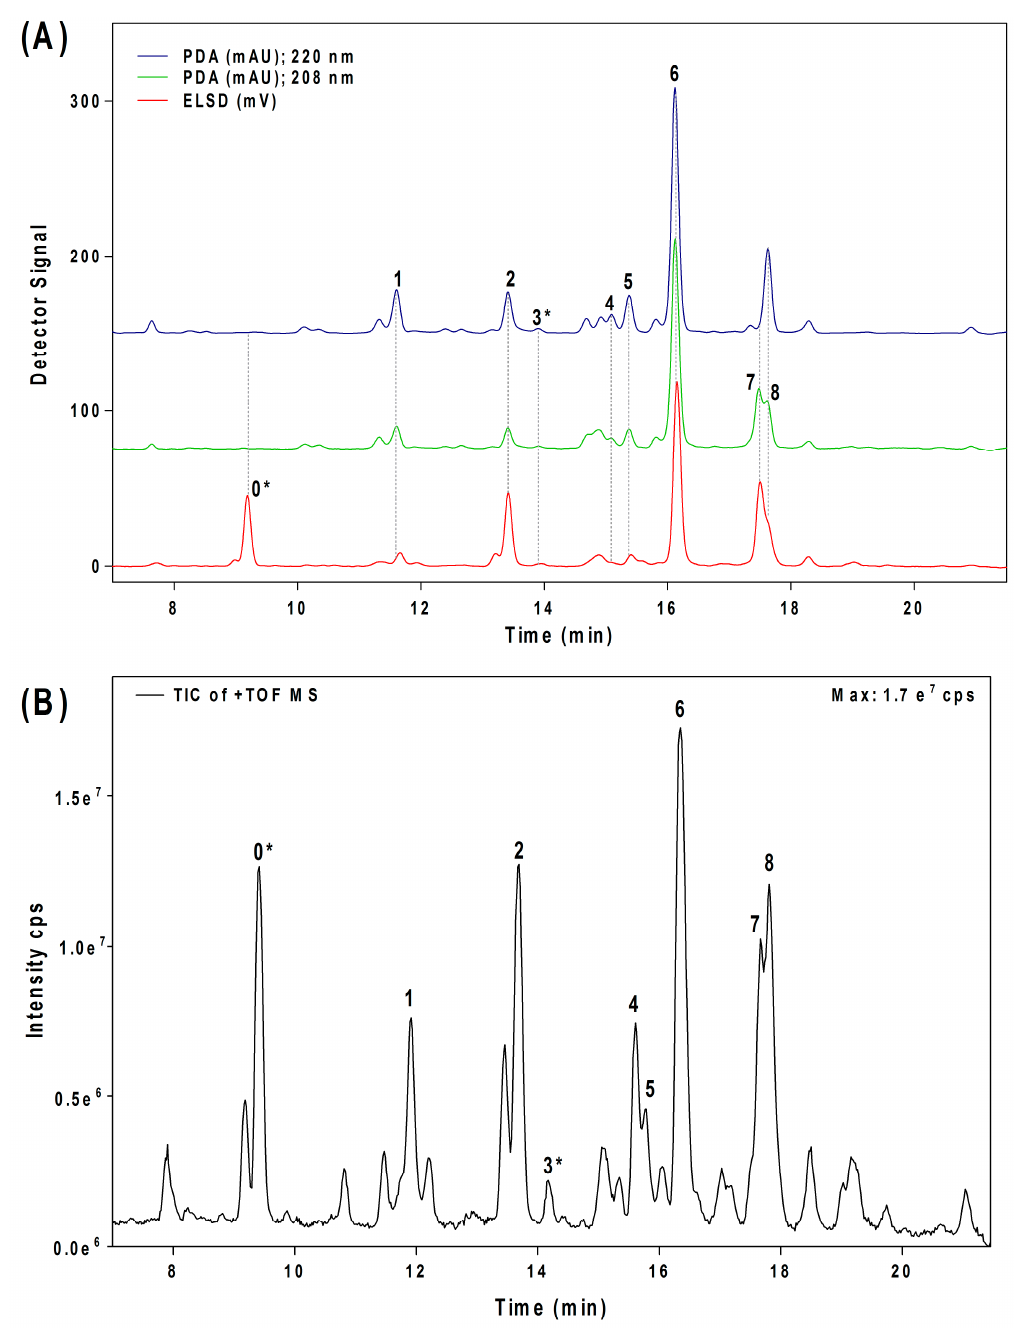
Figure 1. Chromatographic profiles of acetogenin molecules present in a food-grade acetogenin-enriched extract from avocado seed (Avosafe ® ). Panel ( A ) shows chromatograms obtained by HPLC-PDA/ELSD. Panel ( B ) shows chromatograms obtained by HPLC-ESI-TOF-MS. Each numbered peak corresponds to one acetogenin with numbers assigned according to elution order from HPLC column. Table 1 contains complementary information on the chemical identity of each chromatographic peak. An asterisk indicates the compounds with chemical structures assigned in this work.